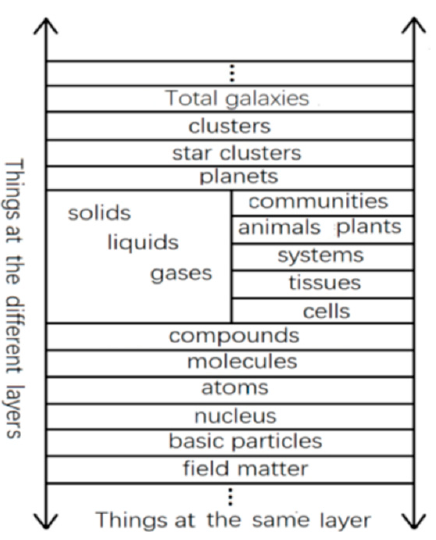
Figure 1. Continuity and discontinuity, diversity and unity of the material world.